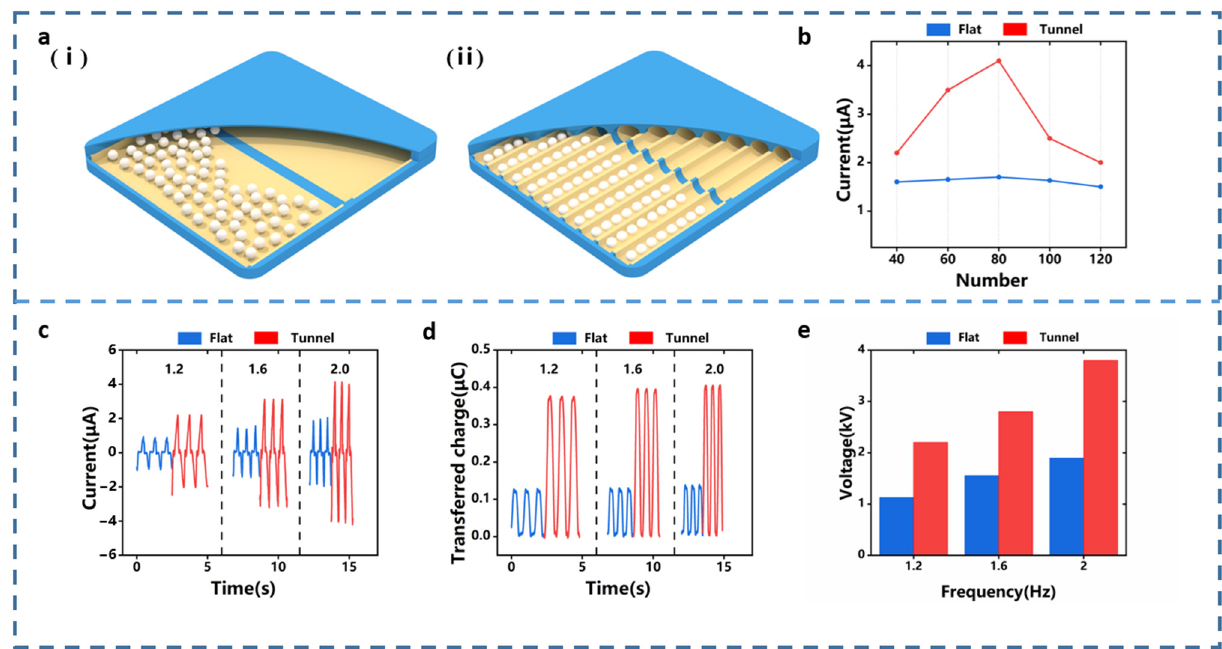
Figure 2. The output performance comparison of the MT-TENG and the flat type TENG. ( a ) Partial sectional view of (i) the flat type TENG and (ii) the multi-tunnel TENG. ( b ) The short circuit current of the MT-TENG and the flat type TENG under different number of PTFE balls ( c ) The short-circuit current I sc , ( d ) short-circuit transferred charge Q sc and ( e ) open-circuit voltage V oc of the flat type TENG and the MT-TENG with different frequency 1.2 Hz to 2 Hz.